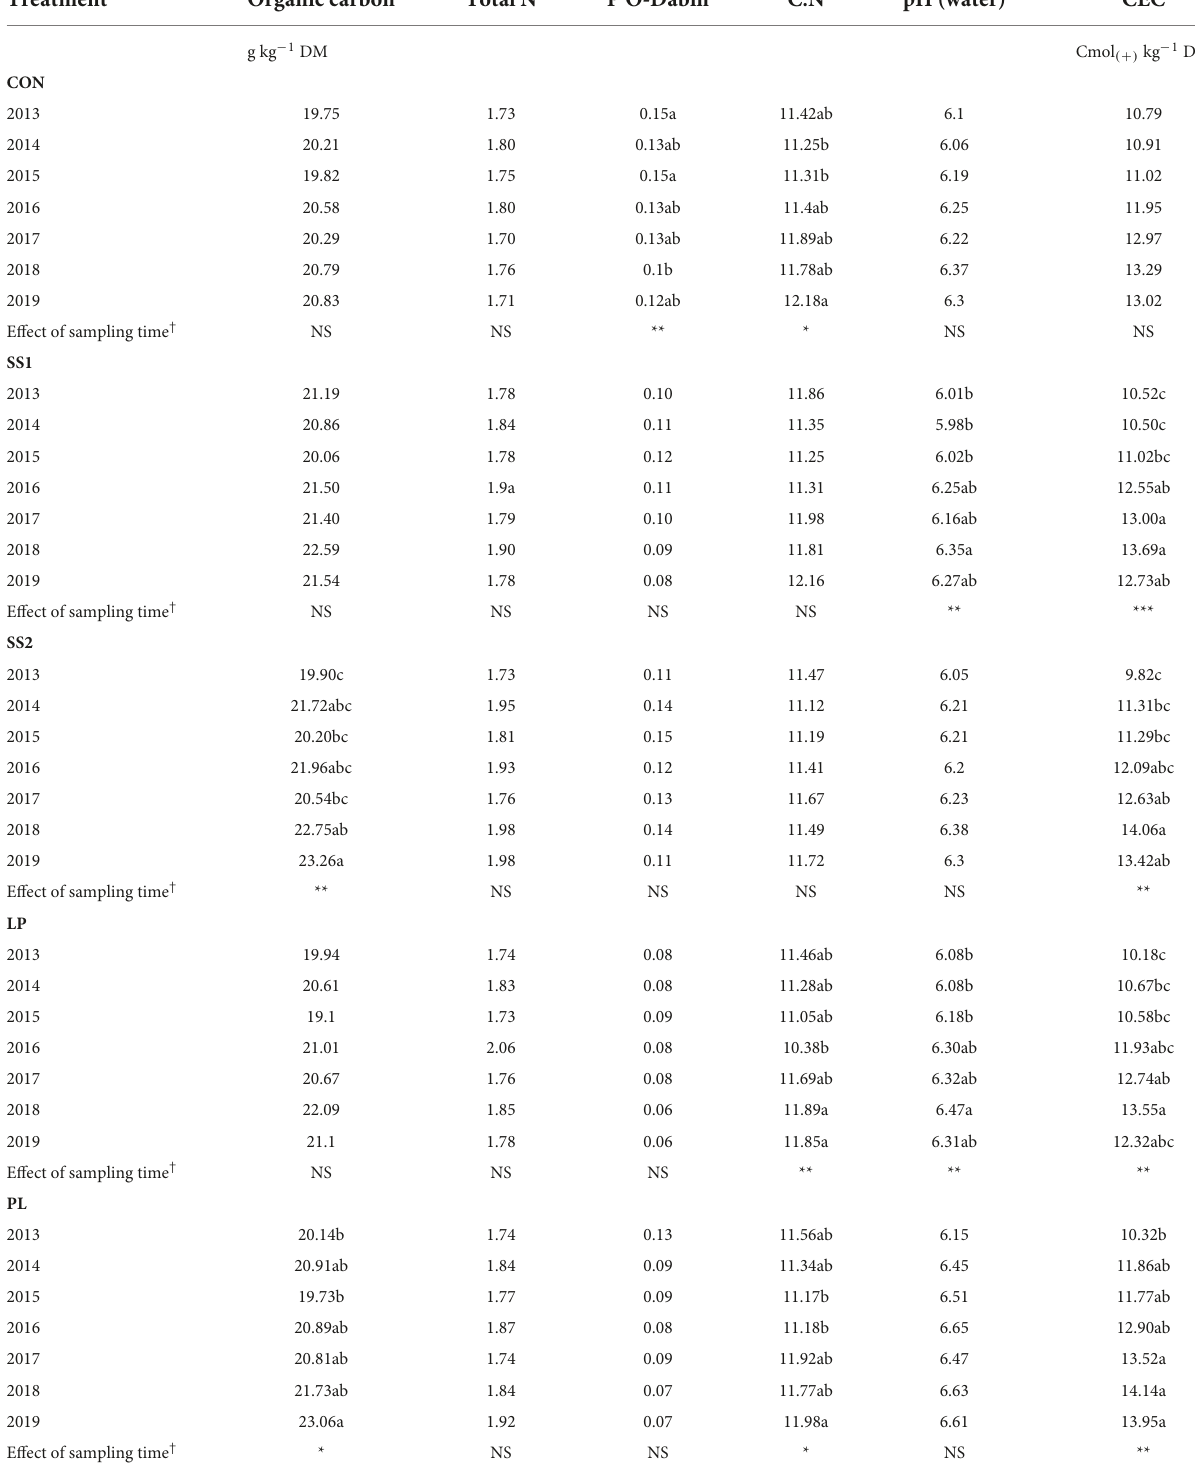
TABLE 1 Physico-chemical parameters of soils from La Mare (Reunion Island) according to the fertilizer input (CON, inorganic fertilized control; SS1 and SS2, sewage sludge inputs; LP, liquid pig manure; PL, poultry litter) and the sampling time. Treatment Organic